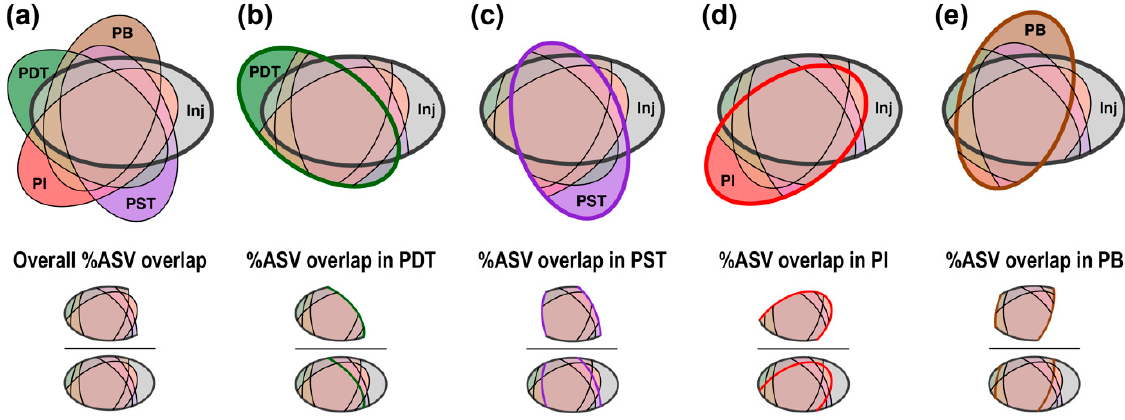
Figure 6. Definition of “%ASV overlap” metric. Overall %ASV overlap denotes the percentage of Inj ASVs that were also detected in any of the producing wells near a certain tracer campaign ( a ). %ASV overlap in PDT/PST/PI/PB denotes the percentage of Inj ASVs that were also detected in PDT ( b ), PST ( c ), PI ( d ), or PB ( e ), near this tracer campaign.